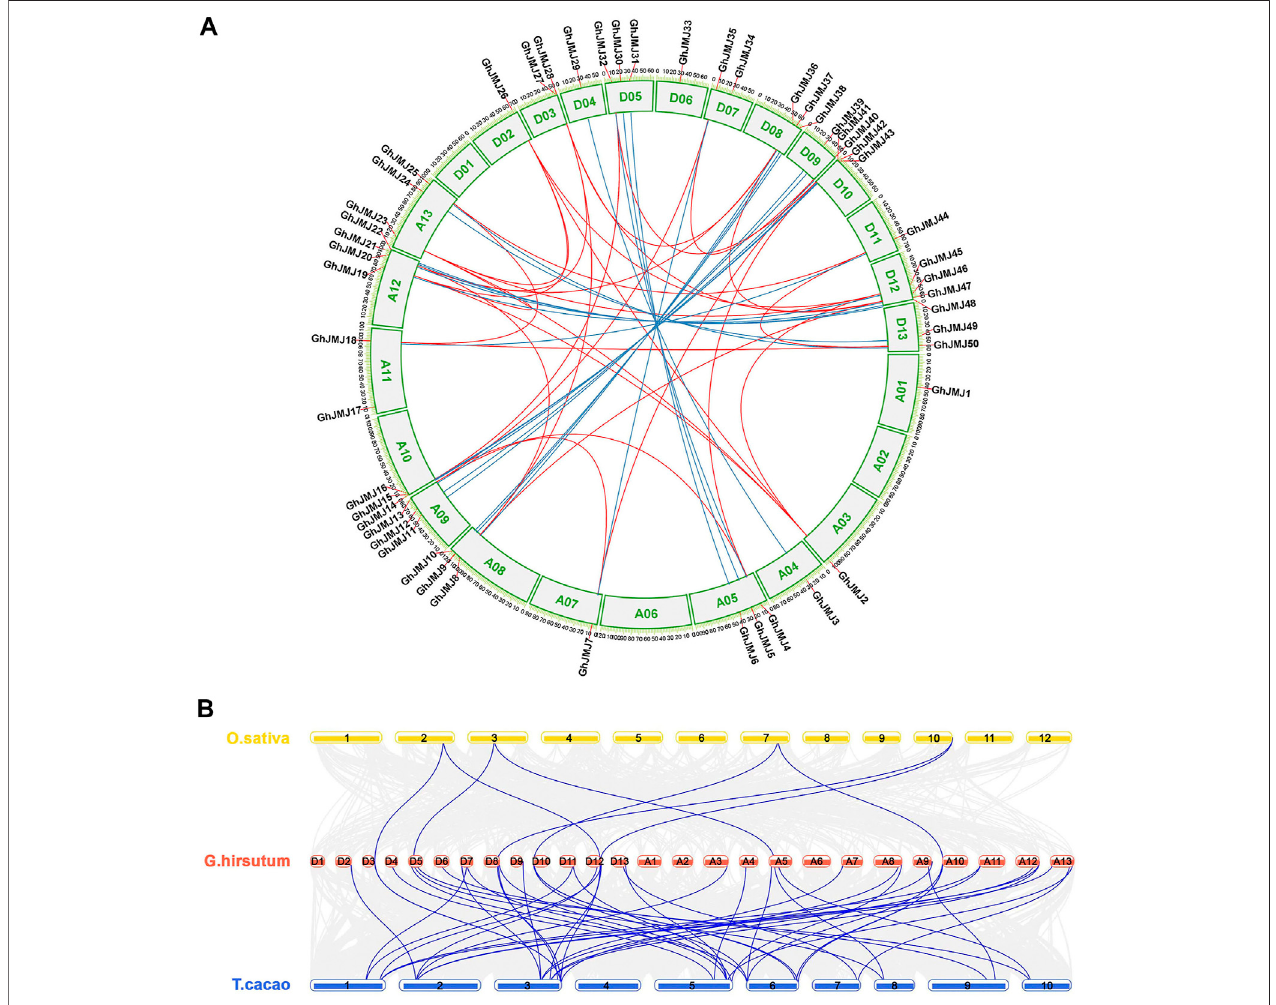
FIGURE 3 | Collinearity analyses of GhJMJ genes in Gossypium hirsutum and synteny analysis of JmjC genes among G. hirsutum , Oryza sativa , and Theobroma cacao . (A) . The chromosomal distribution and collinearity relationships of GhJMJ genes. The blue lines link the orthologous genes, and red lines link paralogous pairs. (B) . Synteny analysis of JmjC genes between G. hirsutum and O. sativa , and between G. hirsutum and T. cacao